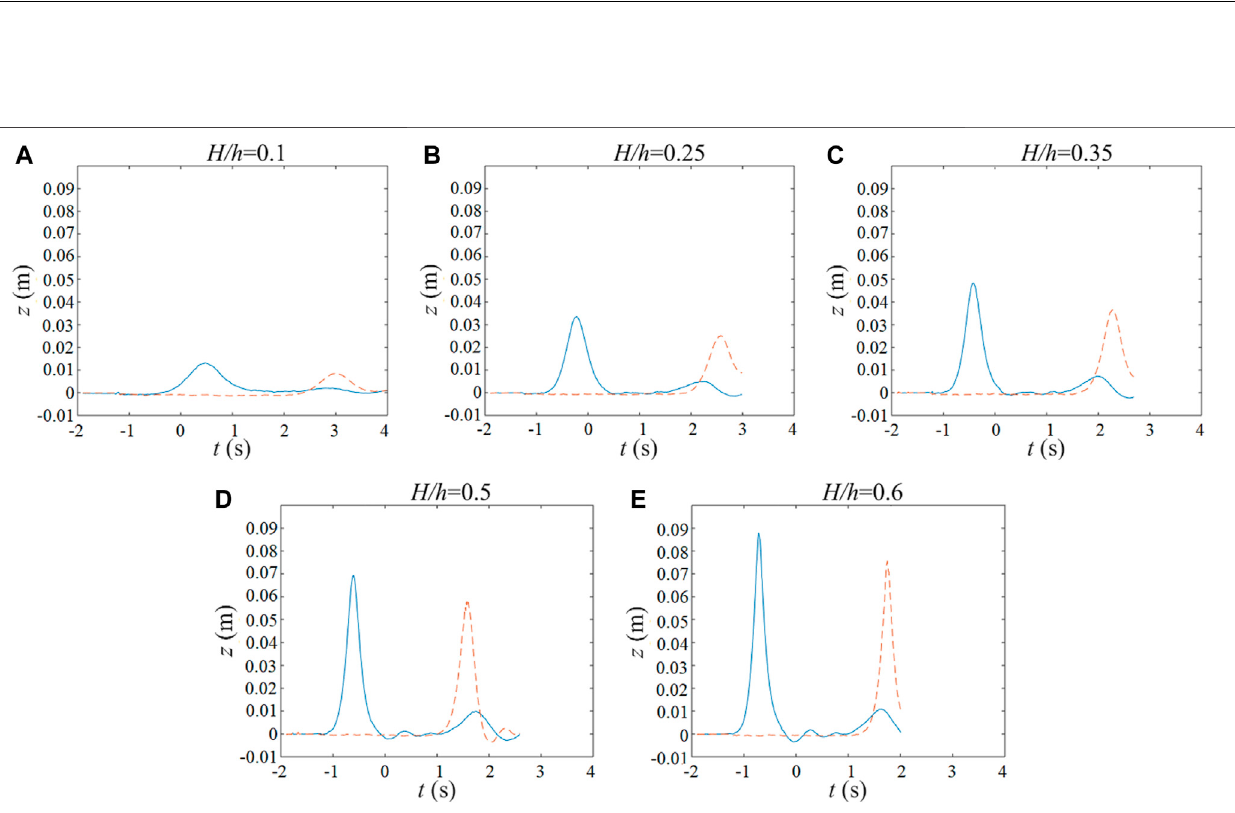
FIGURE 12| (A – E) Timeseries of free surface elevation at x (cid:2) − 1.5 m (blue solid Q19 lines) and x (cid:2) 0.5 m (orangedashed lines) for different incident wave heights.